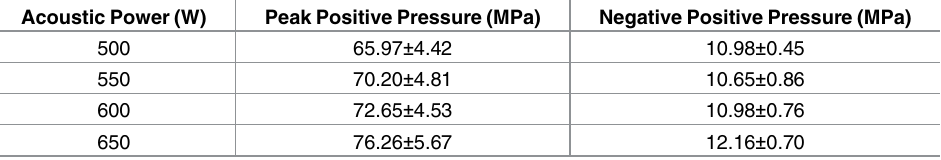
Table 2. Peak positive and negative pressures measuredat varying acoustic powers using a fiber optic hydrophone.